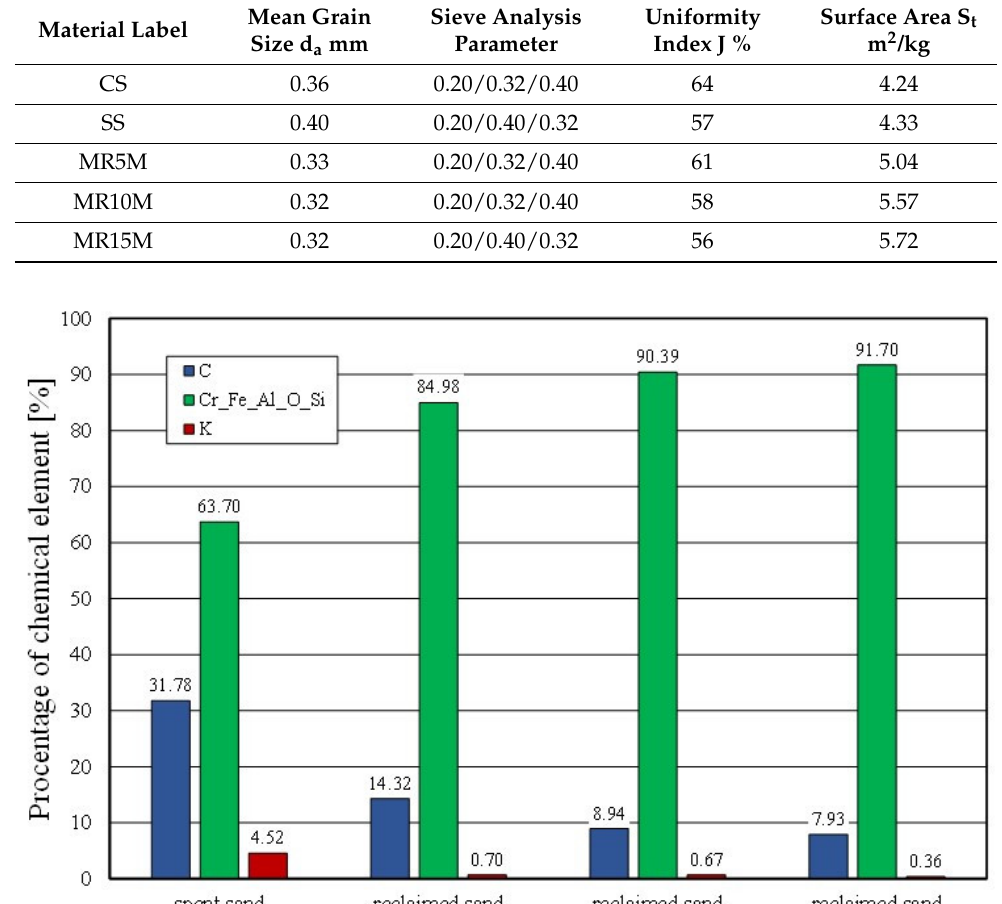
Table 7. Parameters of tested grain matrices as determined by sieve analysis.